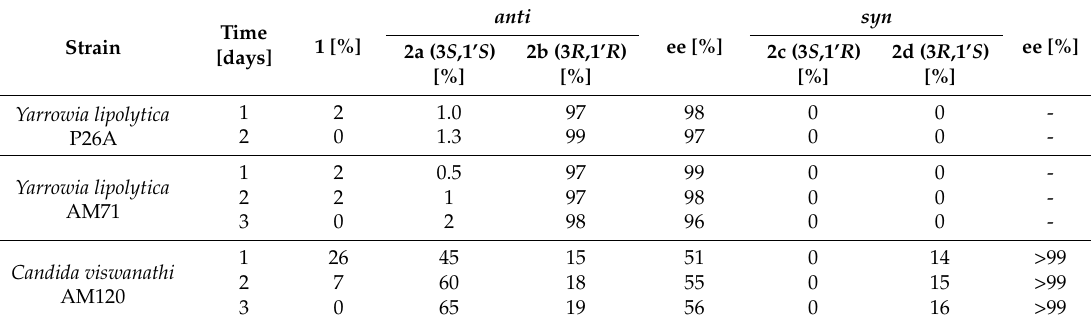
Table 3. The biotransformation of α -acetylbutyrolactone 1 with resting cell cultures (in % according to GC).